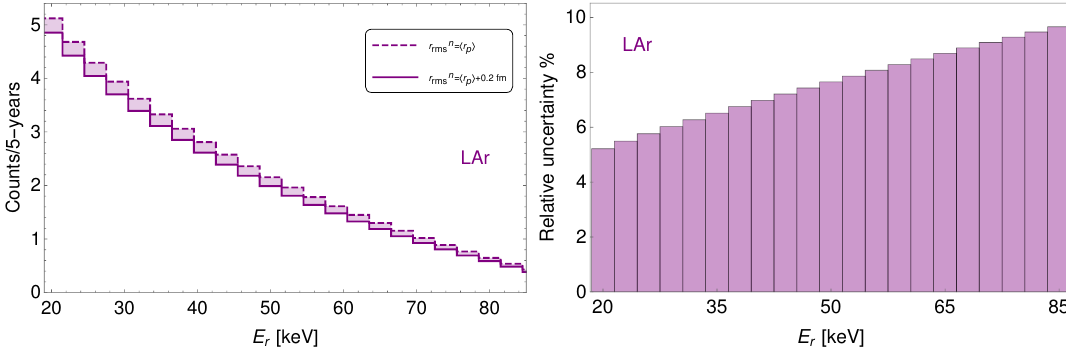
Figure 4 . Recoil spectrum ( left ) and its relative uncertainty ( right ) from DSNB and atmospheric neutrinos at an Ar-based dark matter detector assuming an exposure of 1000 ton-year, as expected for Argo. The dashed (solid) histrograms correspond to r n DSNB contribution is subdominant but not